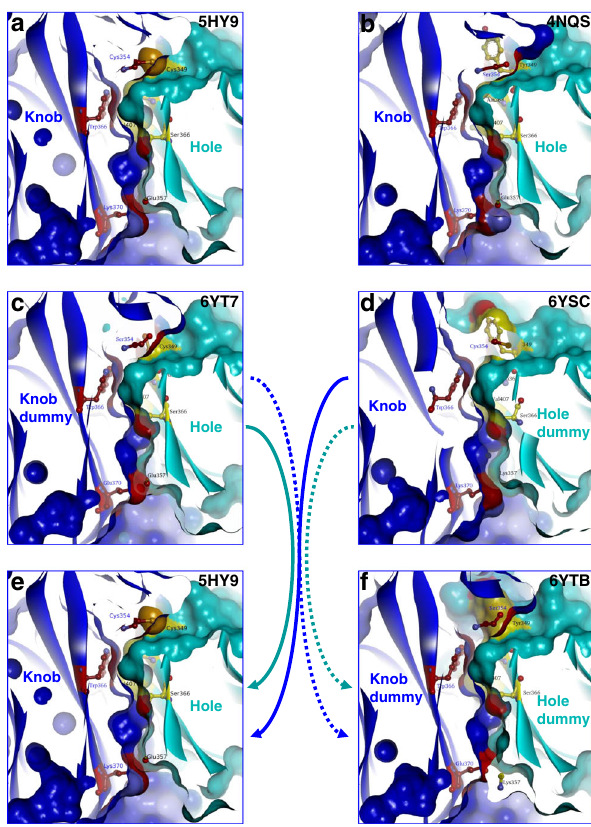
Fig. 2 Dummy-containing Fc heterodimers with CH3 interface mutations that drive exchange reactions. CH3 interface mutations that drive the FORCE reaction were originally designed by modifying the existing 5HY9 structure. After successful generation of dummy Fc containing heterodimers, crystals and structures were generated from those Fcs. Shown here are these structures which con fi rmed the correctness of our initial modeling. a 5HY9 structure 36 is characterized by the KiH mutations in ball and stick, an additional DS 354 – 349, and the salt bridge K370 and E357; b crystal structure of the KiH without DS 25,35 ; the structures C, D, and F were generated as part of this work and are deposited in PDB ID ’ s 6YTB, 6YT7, and 6YSC. c Fc heterodimer with knob-dummy (6YT7); d structure of the Fc heterodimer with hole-dummy (6YSC); e structure of the interchain disul fi de stabilized KiH Fc heterodimer of bsAb products 36 . f Structure of the KiH dummy dimer